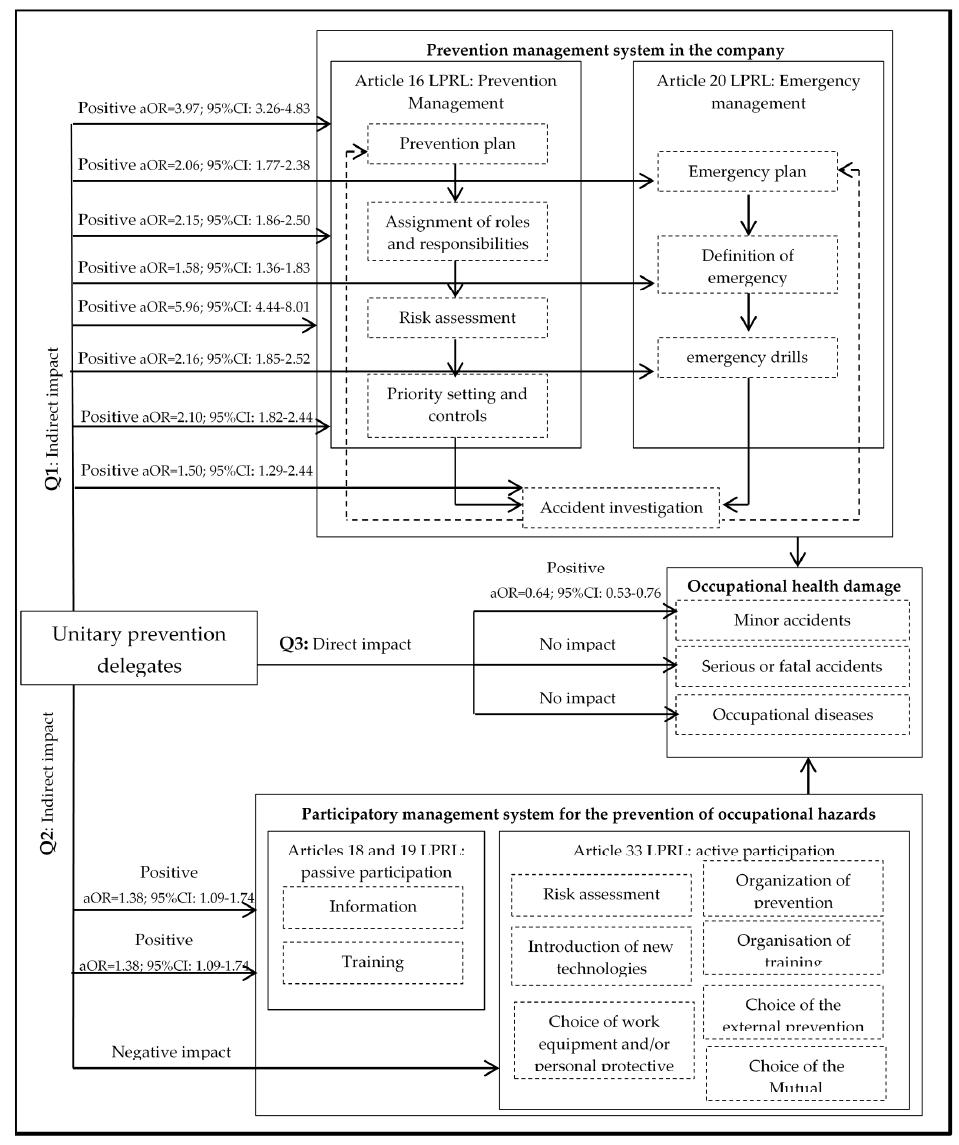
Figure 2. Results of the Participatory Management System for the Prevention of Occupational Risks. Q1